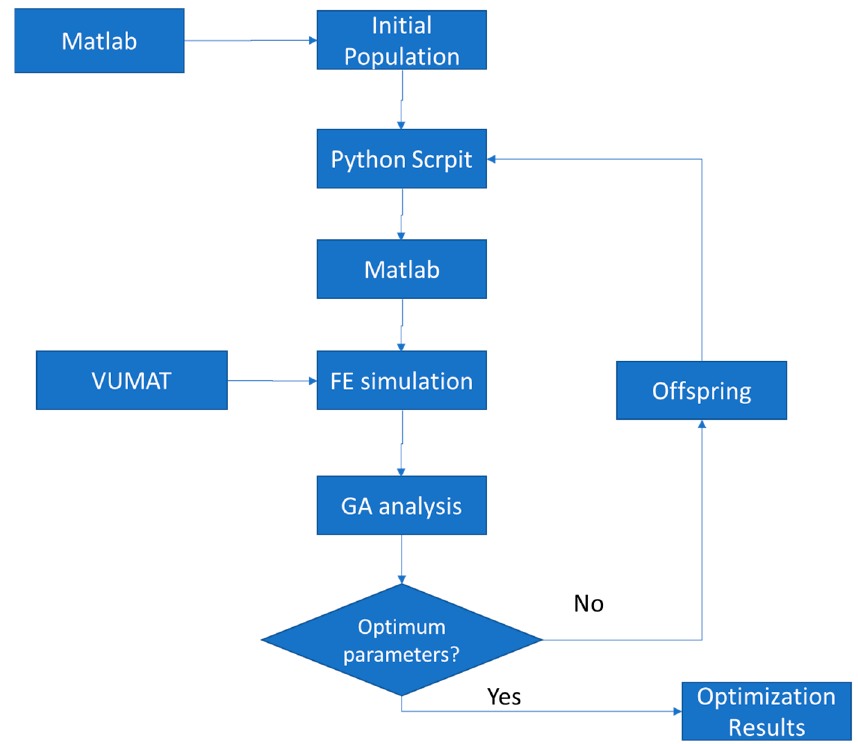
Figure 2 . Analysis flowchart . Figure 2. Analysis